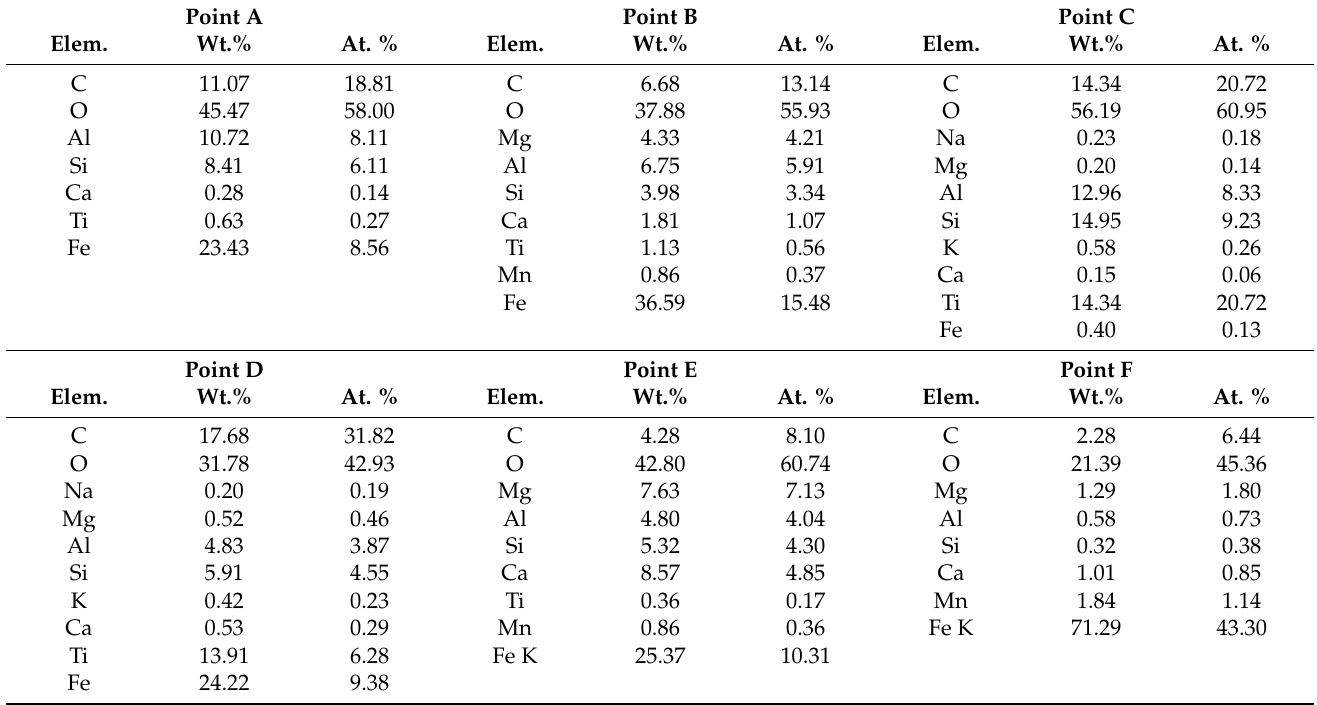
Table 3. The EDS analysis of points in Figure